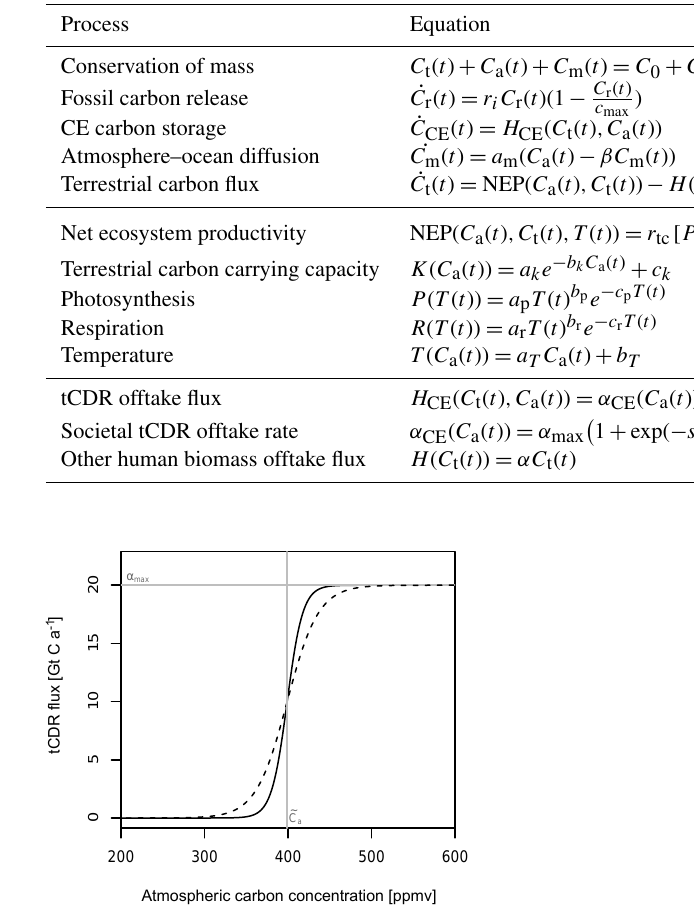
Figure 3. Modelled photosynthesis and respiration rates as a func- tion of global mean land surface